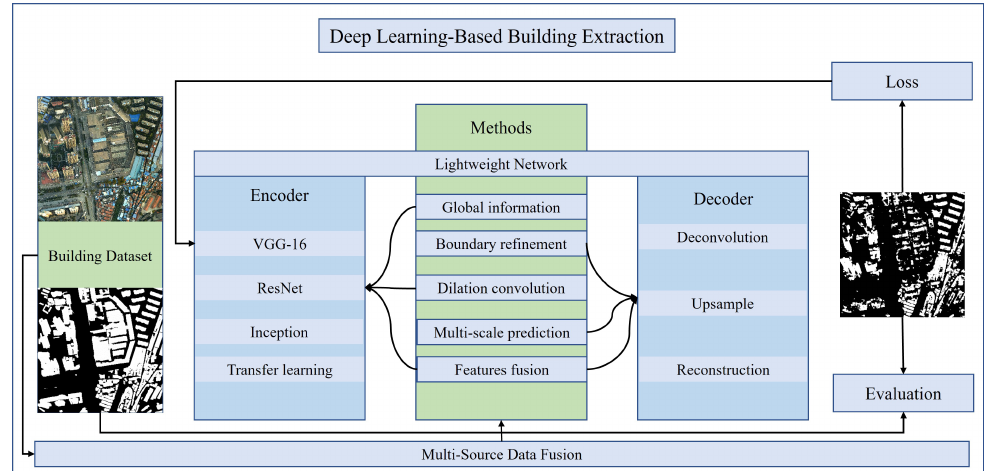
Figure 2. Visualization of the reviewed